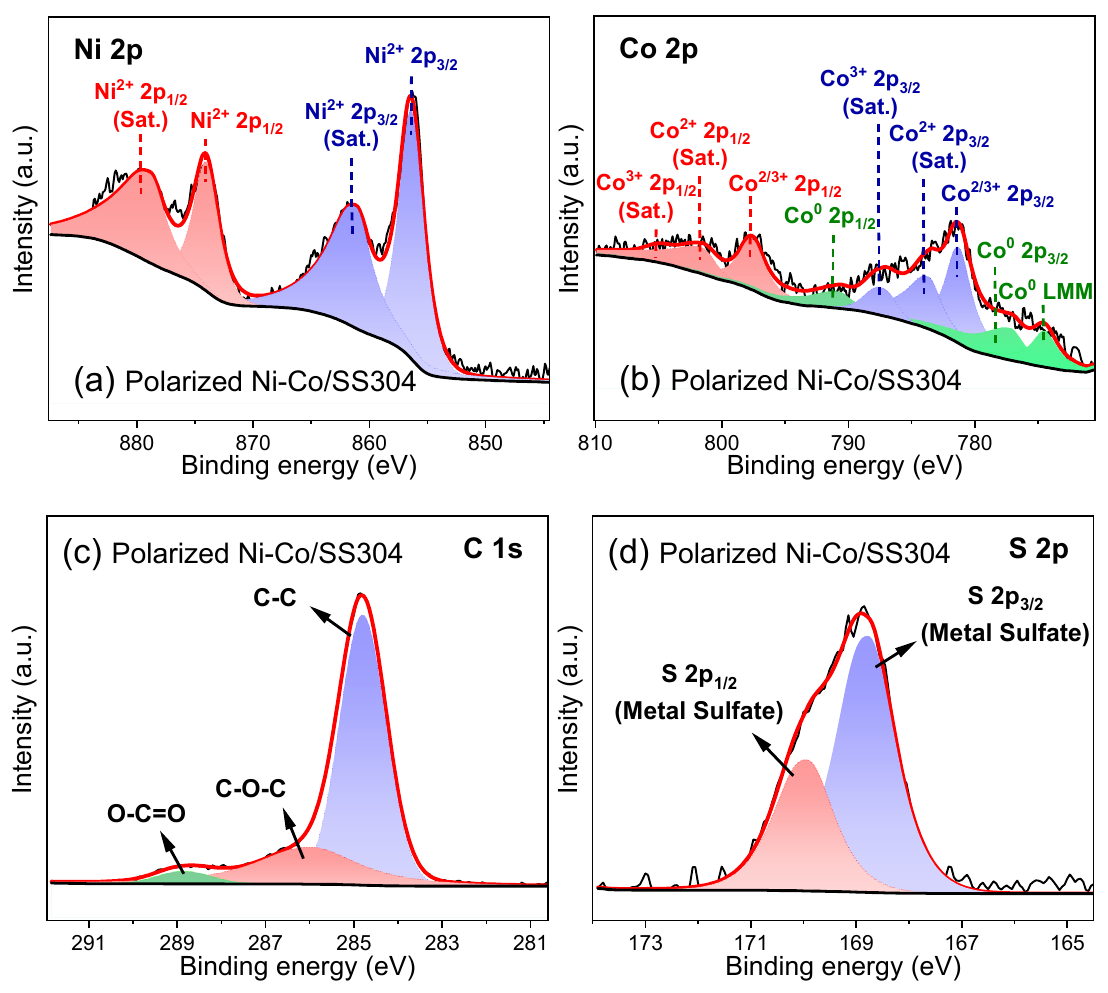
Figure 9. XPS spectra of Ni 2p, Co 2p, C 1s, and O 1s of Ni–Co/SS304 after polarization (0.6 V, 5 h) in the simulated PEMFC cathodic environment.